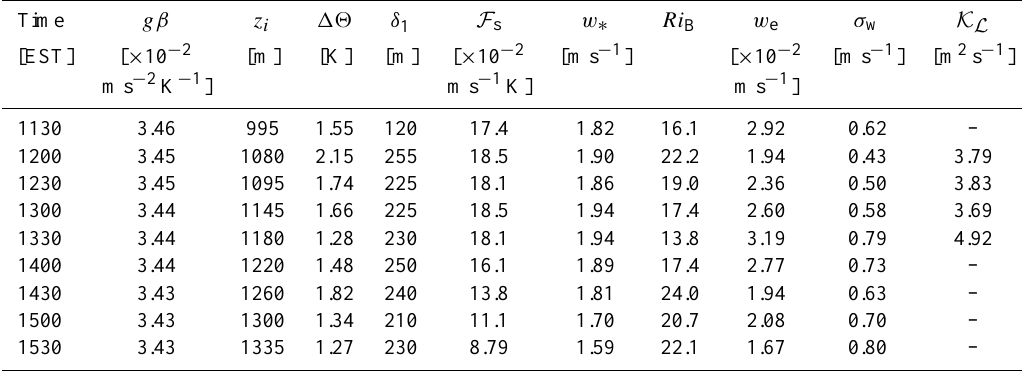
Table 1. Characteristics of the convective boundary layer for the 256 3 resolution